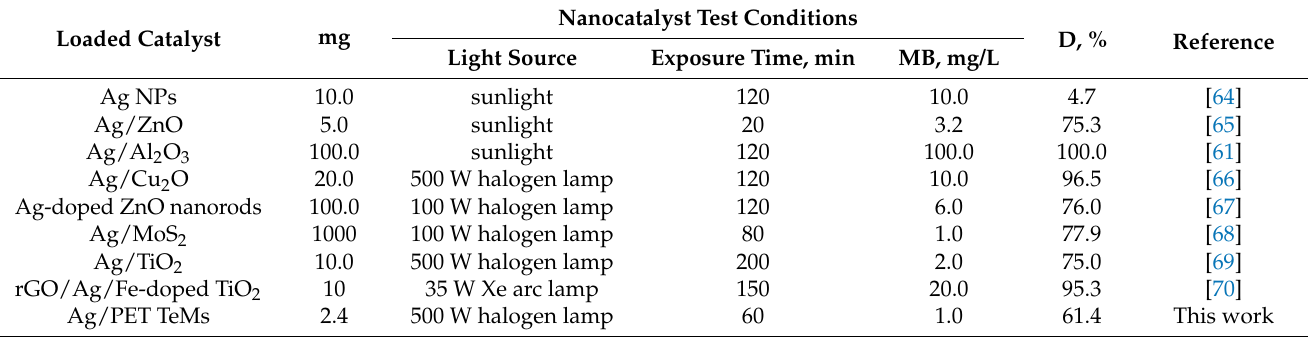
Table 1. Some important features and photocatalytic activity of silver-based nanostructures employed in the MB decomposition. Loaded